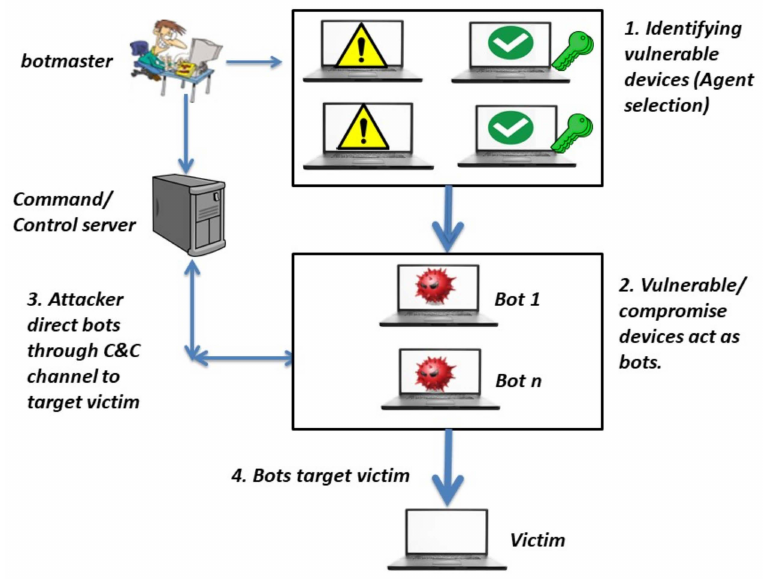
Figure 1. Preparing a botnet for a DDoS